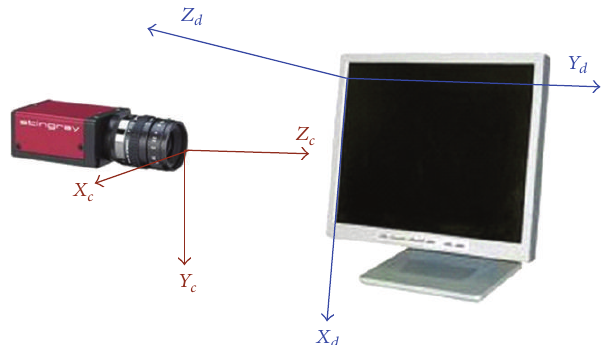
Figure 5: Camera reference frame and display reference frame.